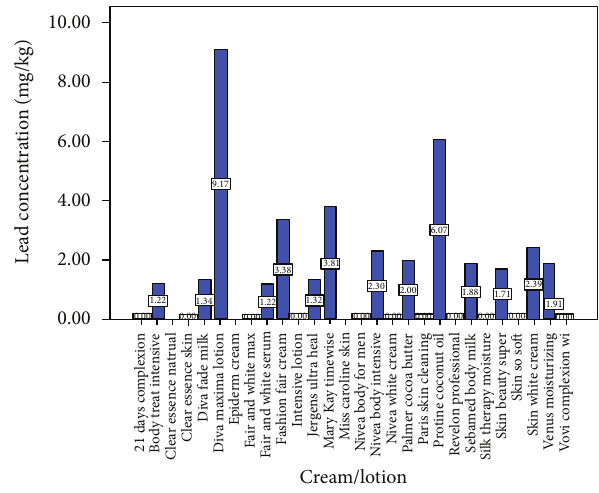
Figure 1: Lead concentration in creams and lotions. Suggested safe levels of Gondal et al. (0.5 ppm), Expert Panel 2007 (0.2ppm), and Germany (1ppm).